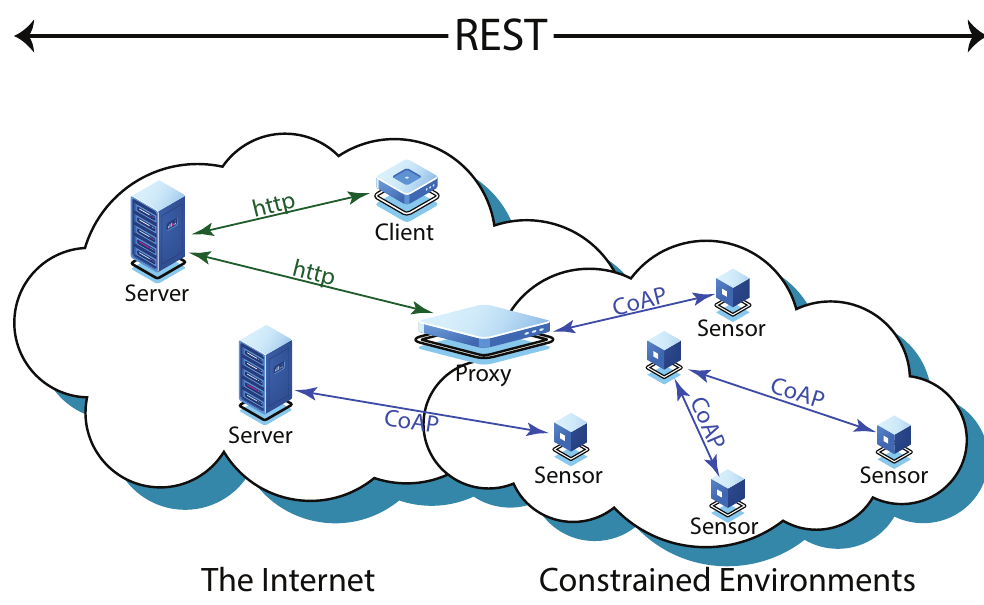
Figure 1. An overview of CoAP